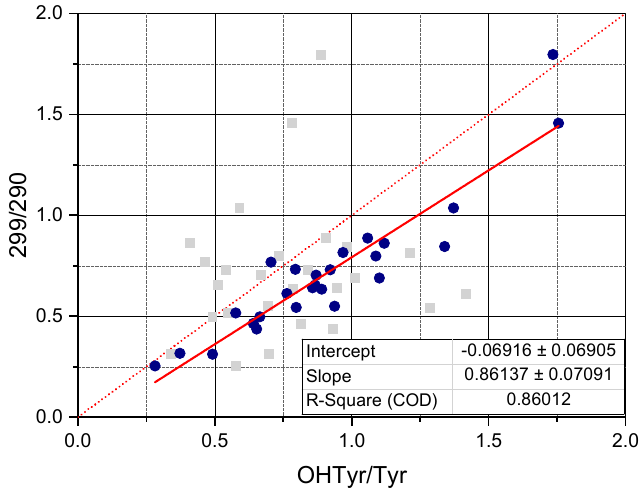
Figure 4. The scatter plot reports the ratio, 299/290, between the second derivative of the absorbance of NADES extracts at 299 nm and the second derivative of the absorbance of NADES extracts at 290 nm versus the ratio OHTyr/Tyr between the content of OHTyr and the content of Tyr, both free (grey scatter) and total (blue scatter). The second derivatives at 299 and 290 have been normalized by the molar extinction coefficient of respectively OHTyr and Tyr. The box reports the parameters of the linear regression of the 299/290 ratio versus the total OHTyr/total Tyr ratio.